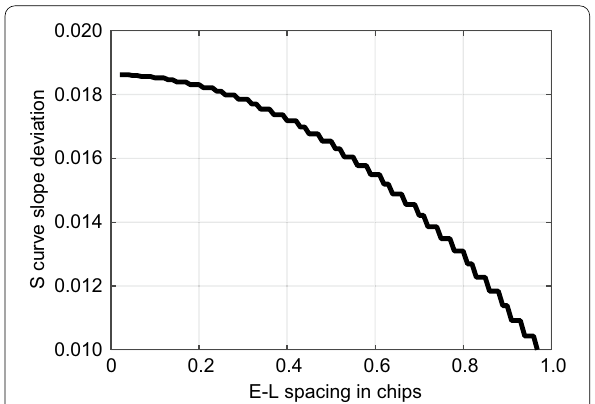
Fig. 16 S-curve slope deviation of BDS-3 GEO-1 PPP-B2b_I